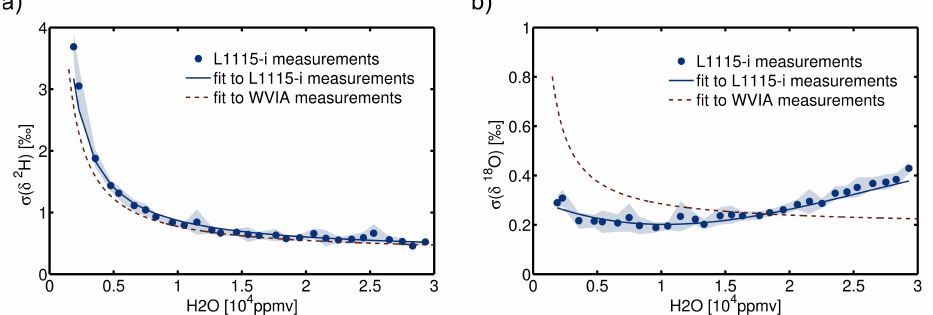
Fig. 5. Dependency of the δ 2 H (a) and δ 18 O (b) measurement precision (average standard deviation σ of calibration runs) on water vapour mixing ratio for L1115-i (solid lines and data points). The fit to the WVIA measurements (dashed lines) found by Sturm and Knohl (2010) is shown for comparison. The shading represents the standard deviation of all calibration runs with four different standards (WS 6–9 in Table 2).